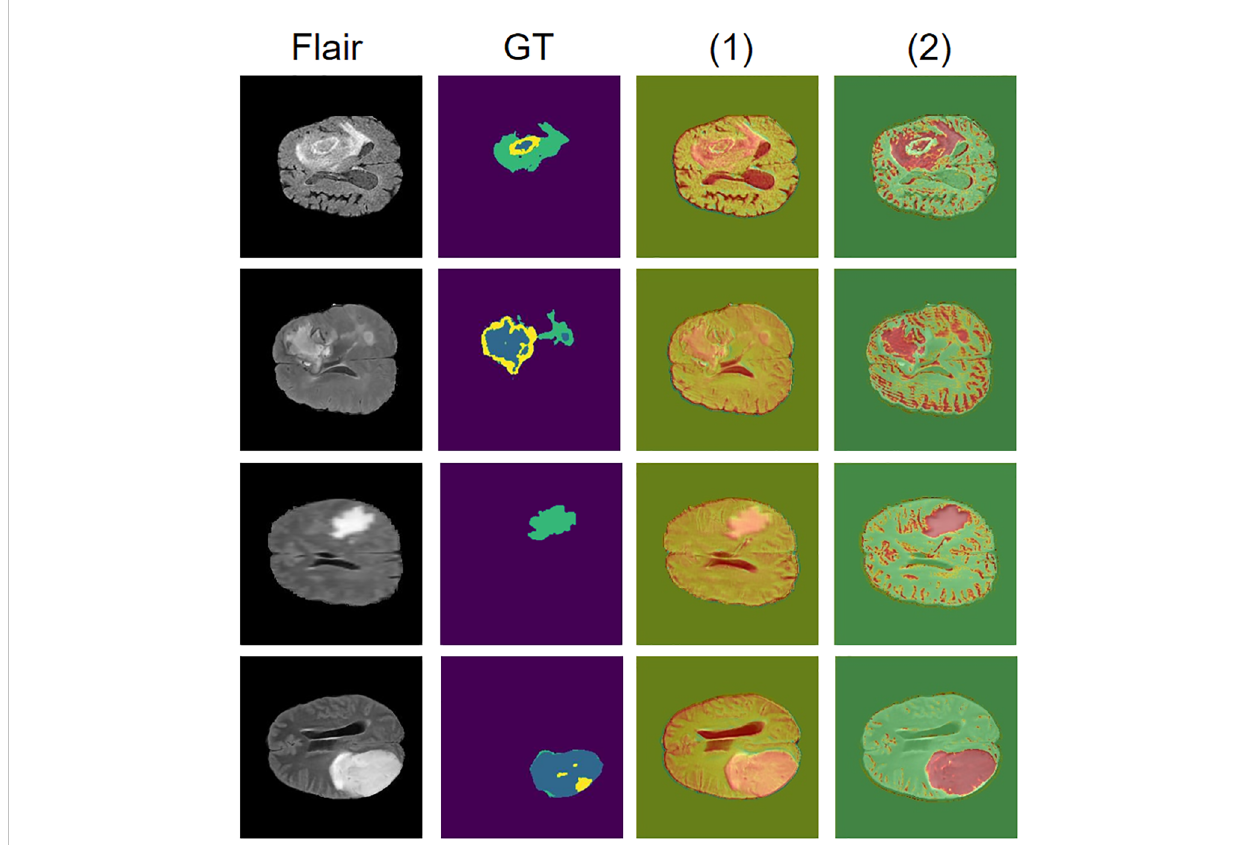
FIGURE 6 Visualization of attention mechanisms. The Flair modality is used as the original image, GT is the ground truth of the segmentation result, and the red area is the region of interest to the network, where (1) is the network model without HAFB and (2) is the network model with HAFB introduced.